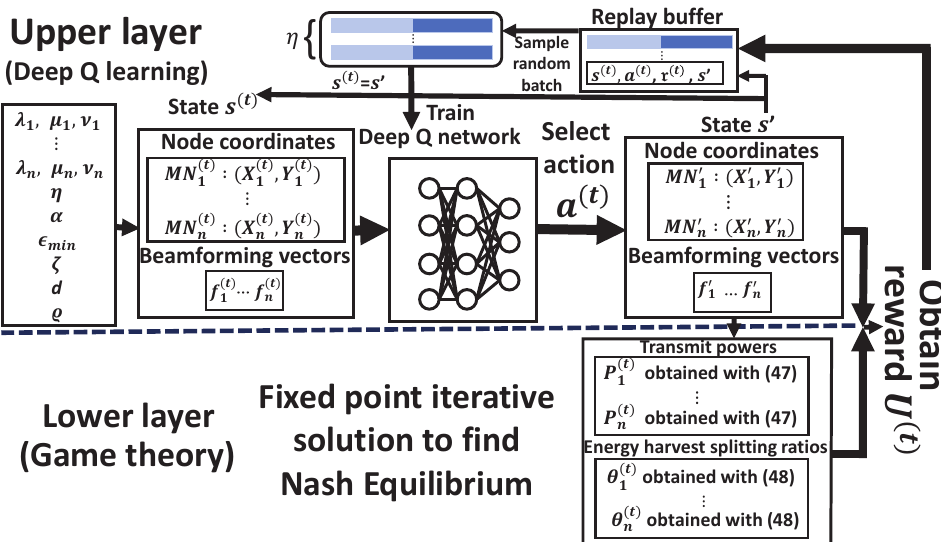
Figure 2. Flowchart of the two-layer hybrid MRA training algorithm. In the upper half, the input and the state (corresponding to line 1 and line 3 in Algorithm 3) are shown by the first box and the second box, respectively (from left to right). After selection (lines 10–14), the new state is shown by the fourth box. In the bottom half, the lower-layer iterations (lines 17–27) are exhibited with a box showing the equations involved. The two halves then cooperatively produce the reward (line 28) shown in the rightmost side toward the remaining boxes at the top denoting the following steps in Algorithm